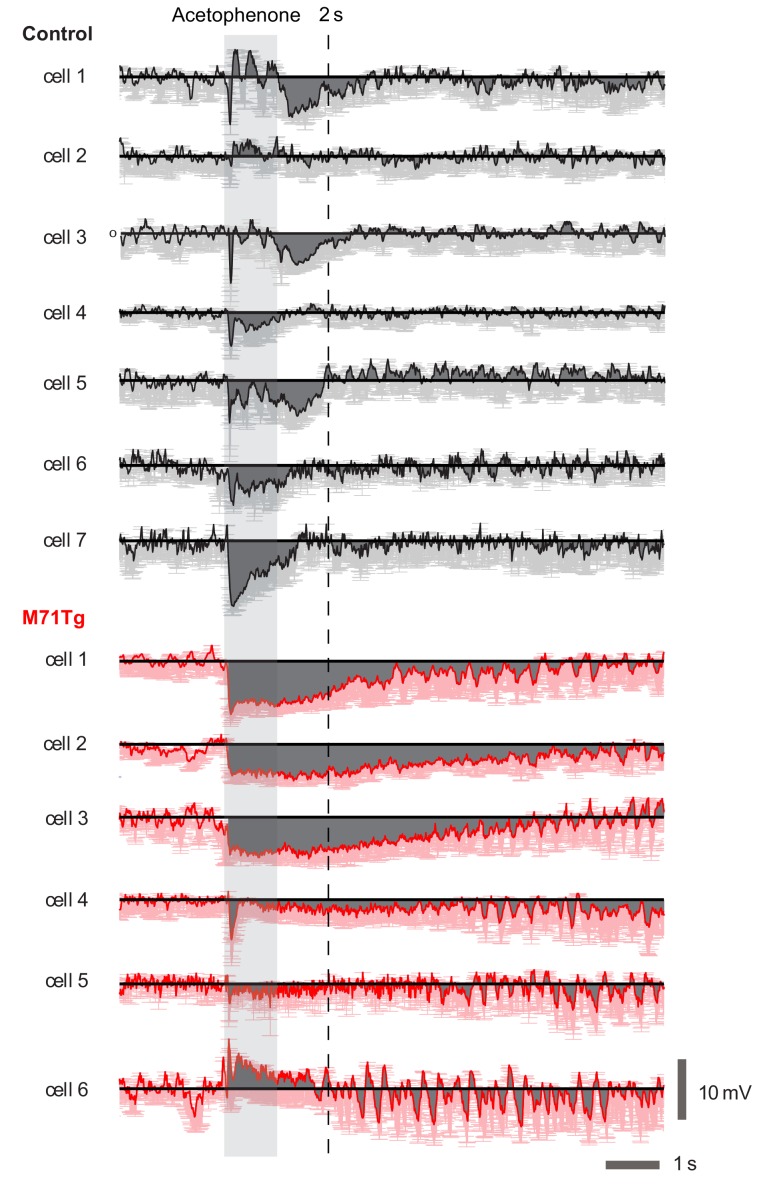
Individual acetophenone response traces.In vivo whole cell recordings in awake mice. Mean spike-clipped traces in response to acetophenone at a concentration of 1% of absolute vapor pressure, averaged across all trials aligned to first inhalation post odor onset for each MTC. In black are traces from each cell recorded in control littermates, in red are traces from M71 transgenic cells. The shaded area shows the 1 s odor stimulus. The dotted line at 2 s is for comparison of the long-duration component of the response. Note the long inhibitory transients seen in 4 of the 6 transgenic MTCs, compared to the much more transient responses in controls.